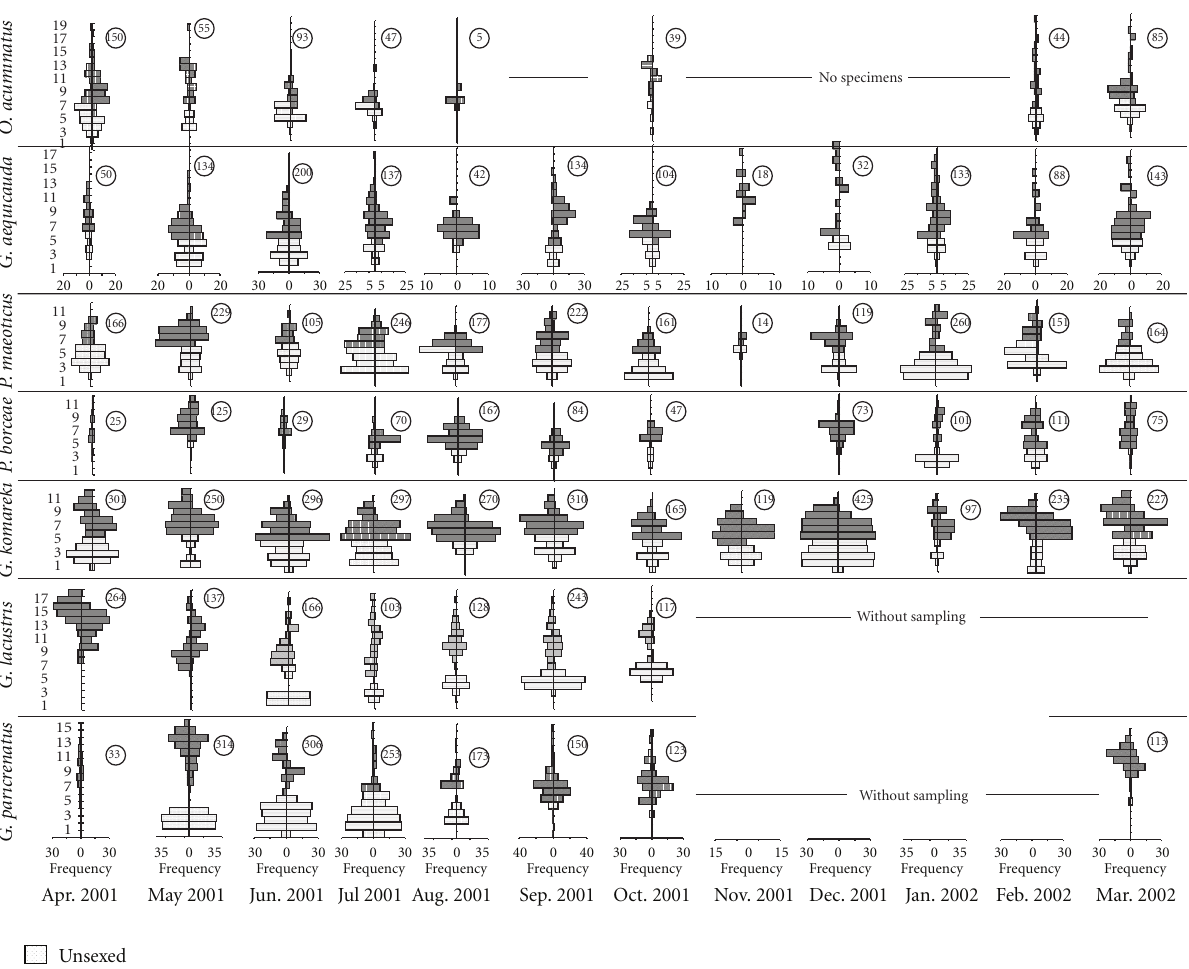
Figure 2: Size and sex composition of studied species during April 2001 to March 2002. The numbers examined are circled.